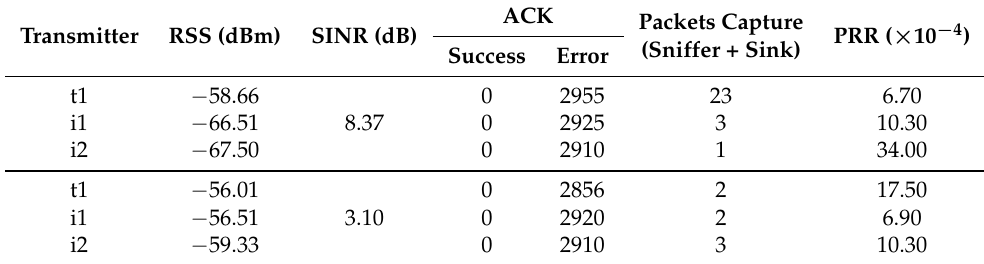
Table 2. PRR values for N i = 2 and N c = 1, using BE = 0. The PRR is almost zero independent of the SINR values. Two experiments are shown to graph the